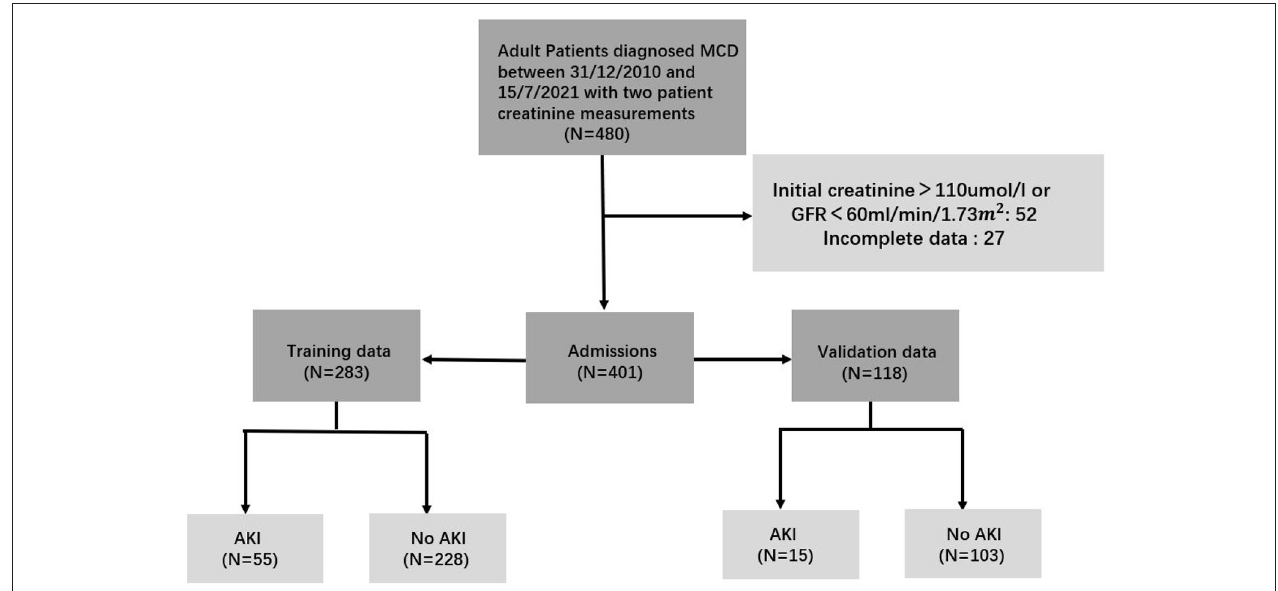
FIGURE 1 | Flow diagram of the patient cohort. To build up the prediction model, the study population was divided into training and validation